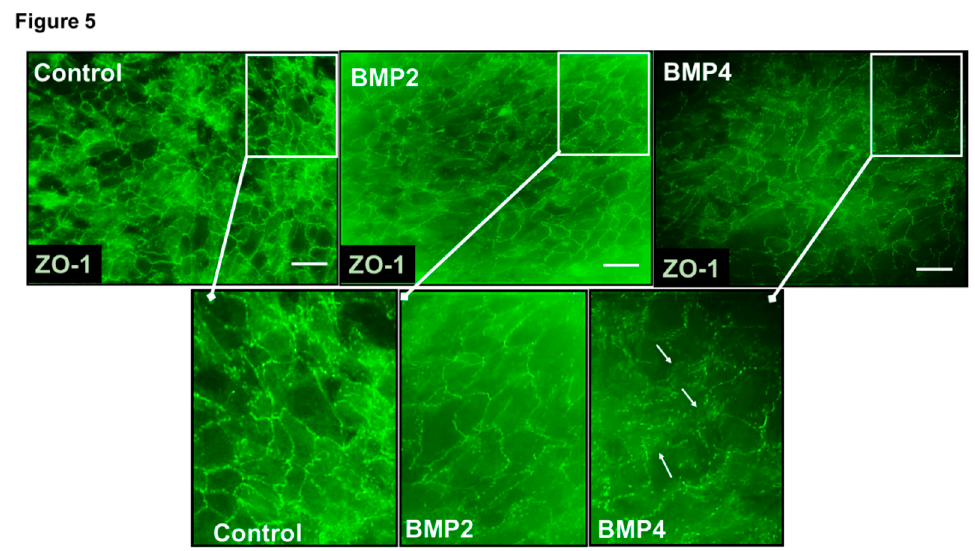
Figure 5. Representative photographs of ZO-1 immunofluorescence (green) in ARPE-19 cells treated with BMP2 or BMP4 versus vehicle-treated controls. Enlarged pictures were shown in squares and the arrows are pointing to the punctate pattern alteration in ZO-1 distribution at cellular border of BMP4-treated ARPE-19 cells; n = 4/group; scale bar = 100 µm.